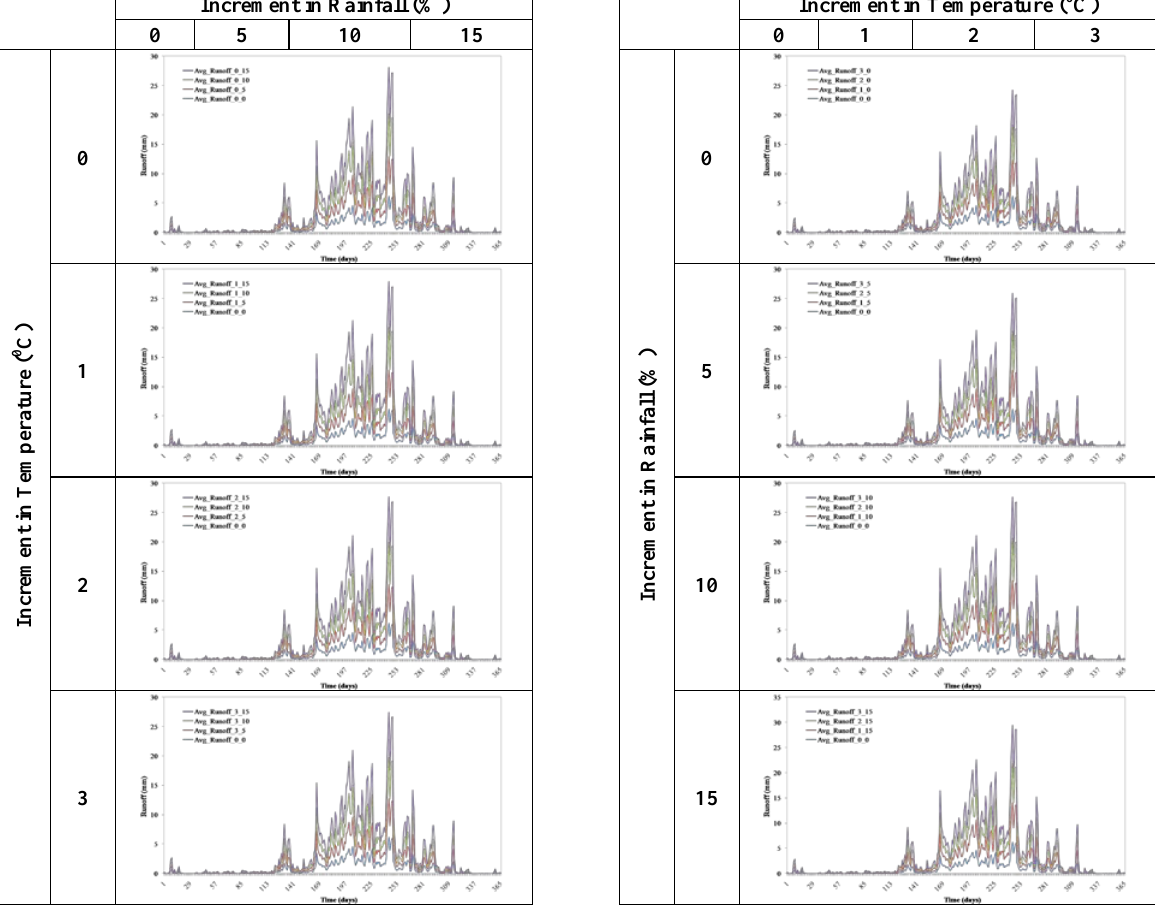
Figure 4. Time series of estimated runoff of each